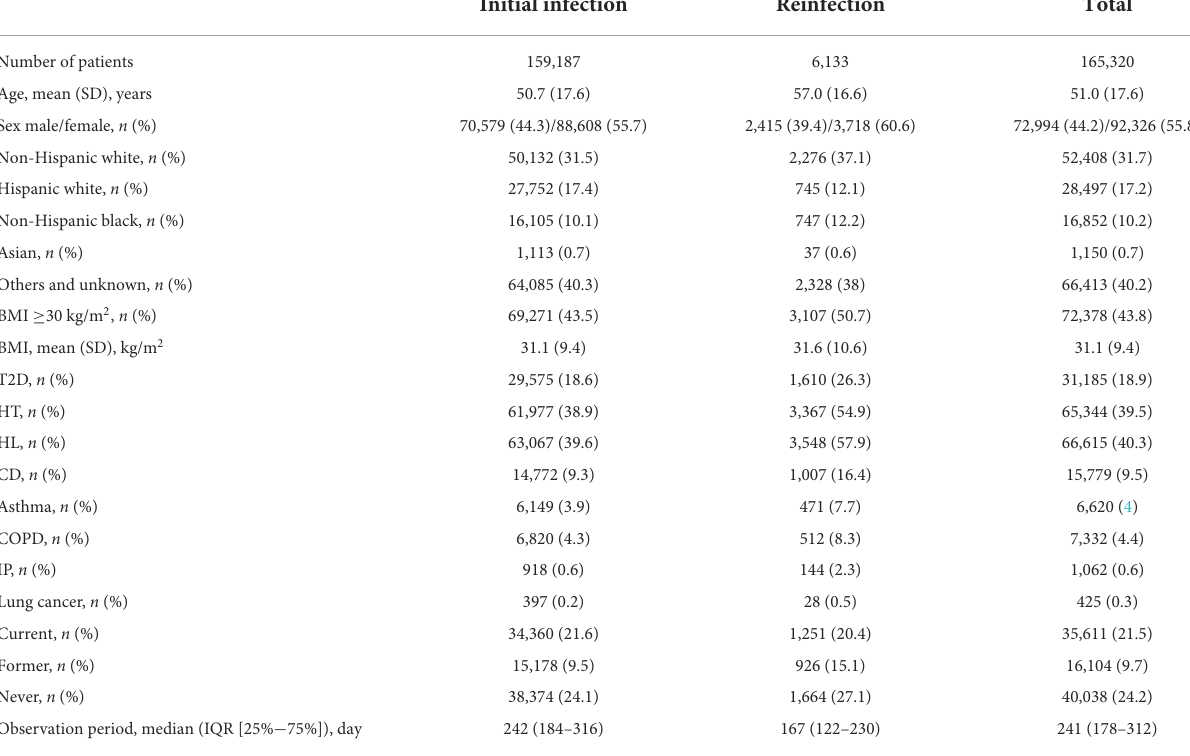
TABLE 1 Characteristics of patients with COVID-19 during initial infection and reinfection.